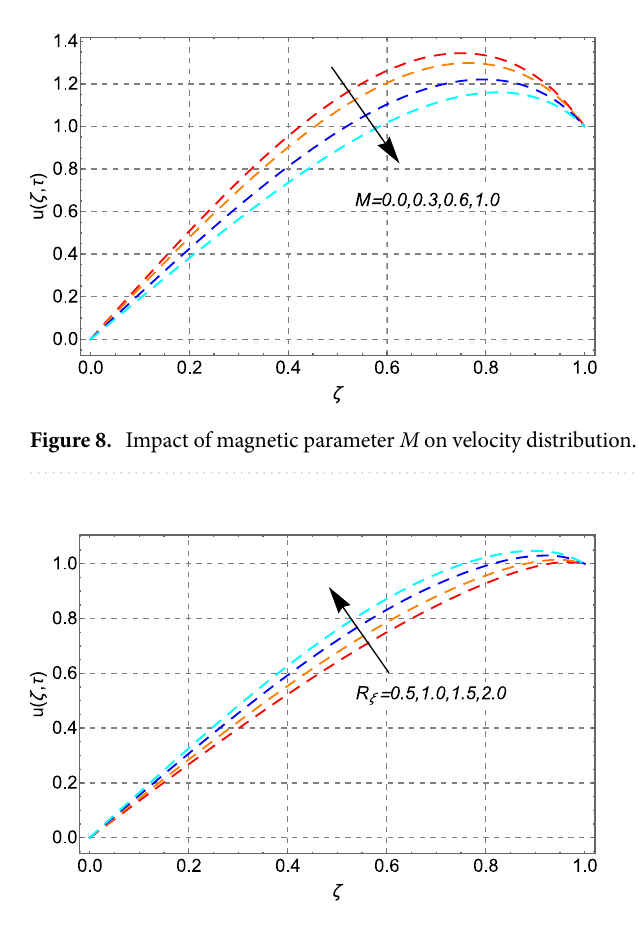
Figure 9. Impact of zeta potential ratio R ξ on velocity